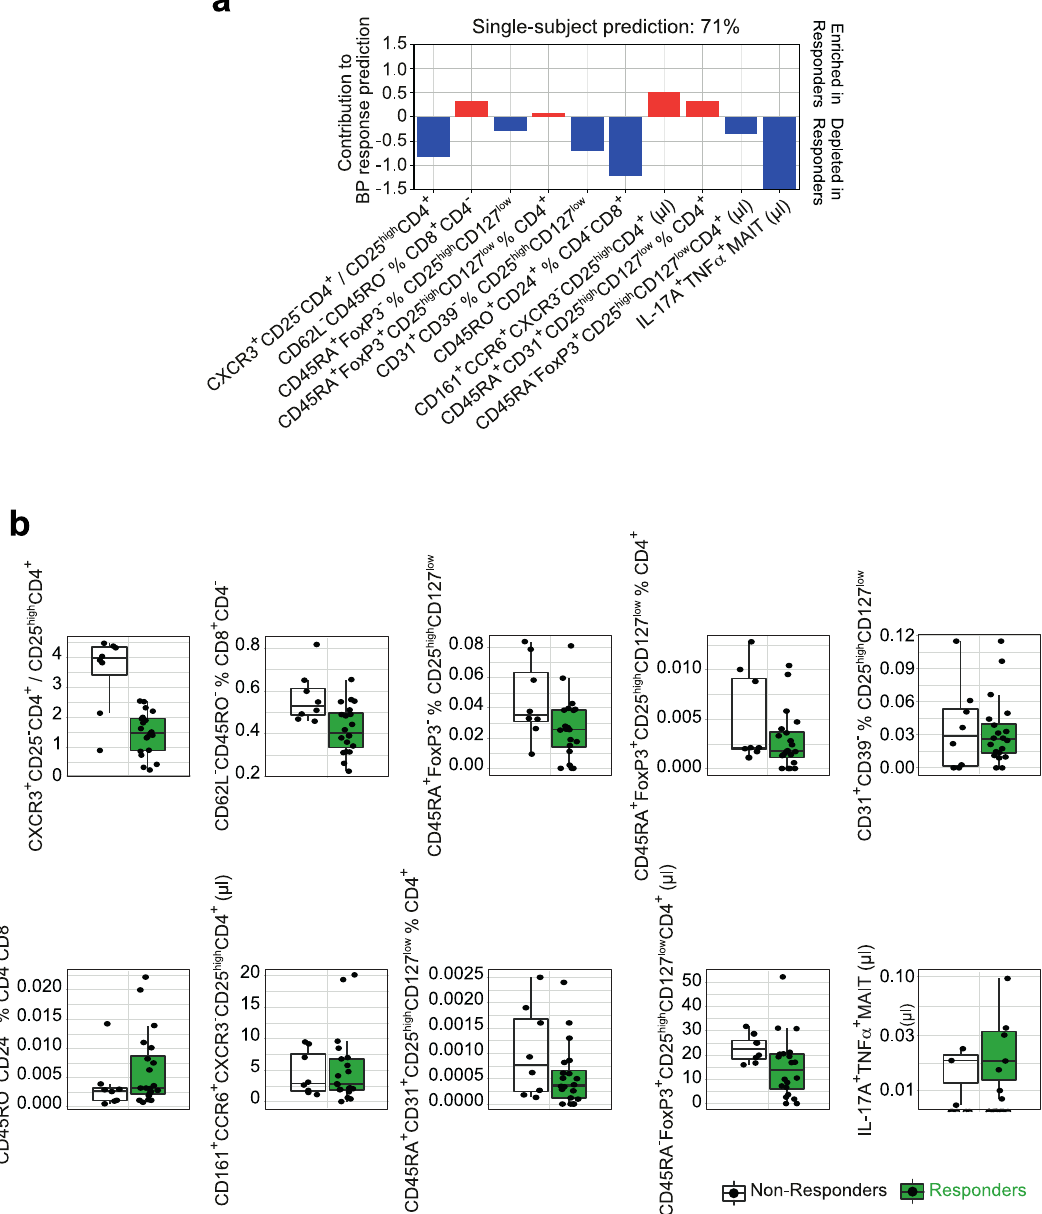
Fig. 7 Long-lasting BP responders and non-responders differ in immunome composition. a Prediction model weights for BP response using the immunome dataset at baseline. The top ten immunome features were used to build a multivariate logistic-regression algorithm. Single-subject prediction was quanti fi ed using a leave-one-out cross-validation procedure. The bar plots represent the regression in a model with binary output (responder yes = 1 vs. no = 0) for every feature. b Quanti fi cation of the immunome features at baseline used in the prediction model to predict BP response in the future, split into responders and non-responders. MAIT: V α 7.2 + CD161 + CD4 − CD3 + . Boxplot hinges denote 25th – 75th percentile. Line within the boxplot indicates median. Whiskers are drawn to minimum and maximum values, but not further than 1.5 ×